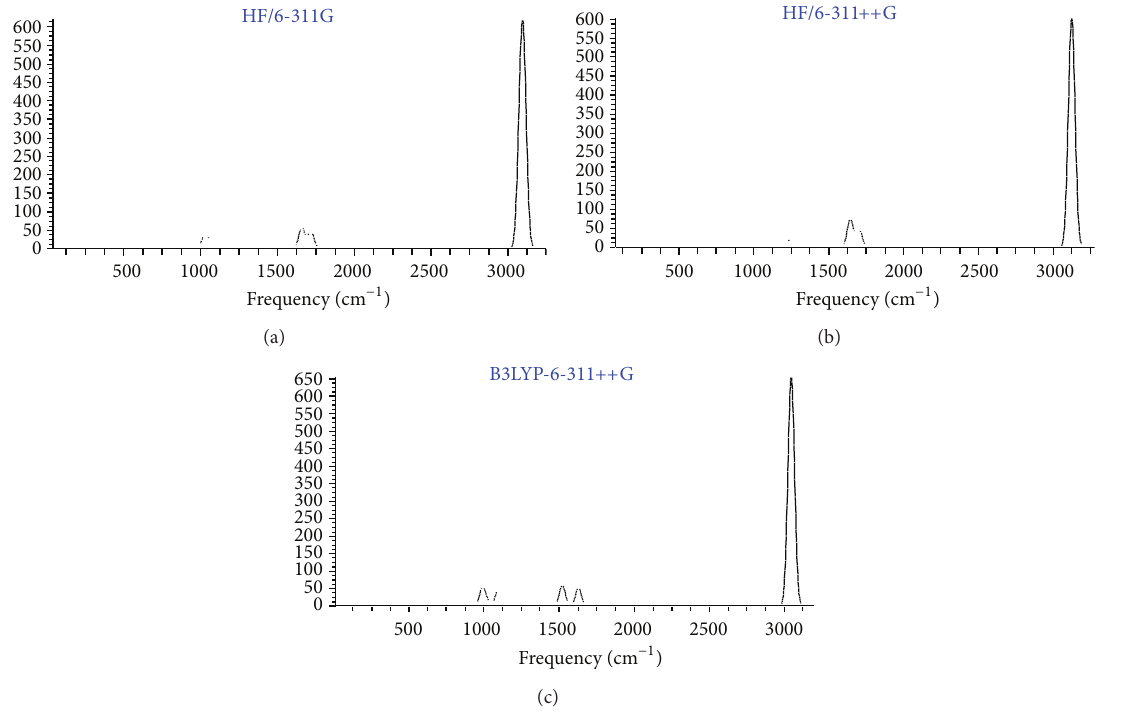
Figure 5: Theoretical FT-Raman spectrum of